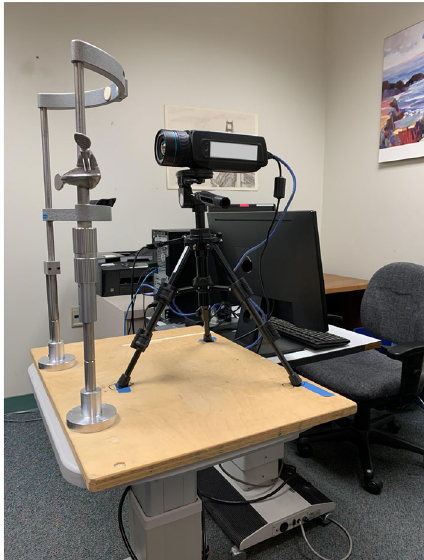
Figure 1. FLIR thermographic camera setup.